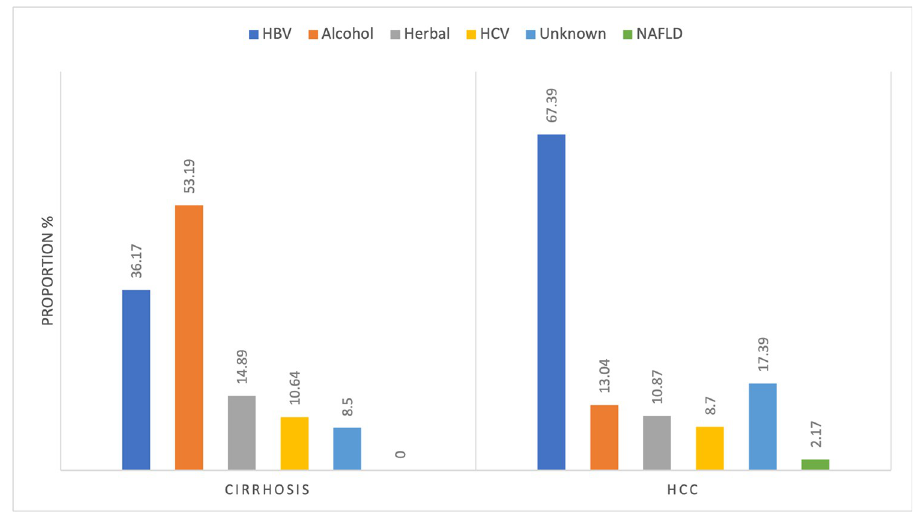
Fig 3. Proportion of risk factors for cirrhosis and HCC in patients seen at a tertiary referral centre in Ghana. Abbreviations: HBV- Hepatitis B Virus, HCV- Hepatitis C Virus, NAFLD- Non-alcoholic Fatty Liver Disease.